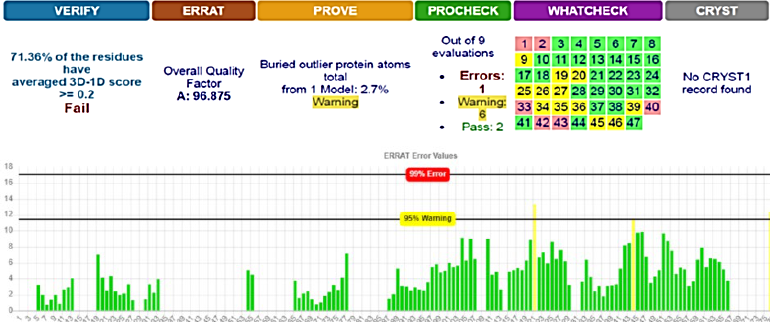
Figure 1. SAVES results for the first selected model. The results of the . SAVES software were compared between the model obtained from SWISS- MODEL and the model after YASARA Swiss model results were better in terms of overall quality, the warning percentage, and Ramachandran plot. Estimated overall quality factor by ERRAT was